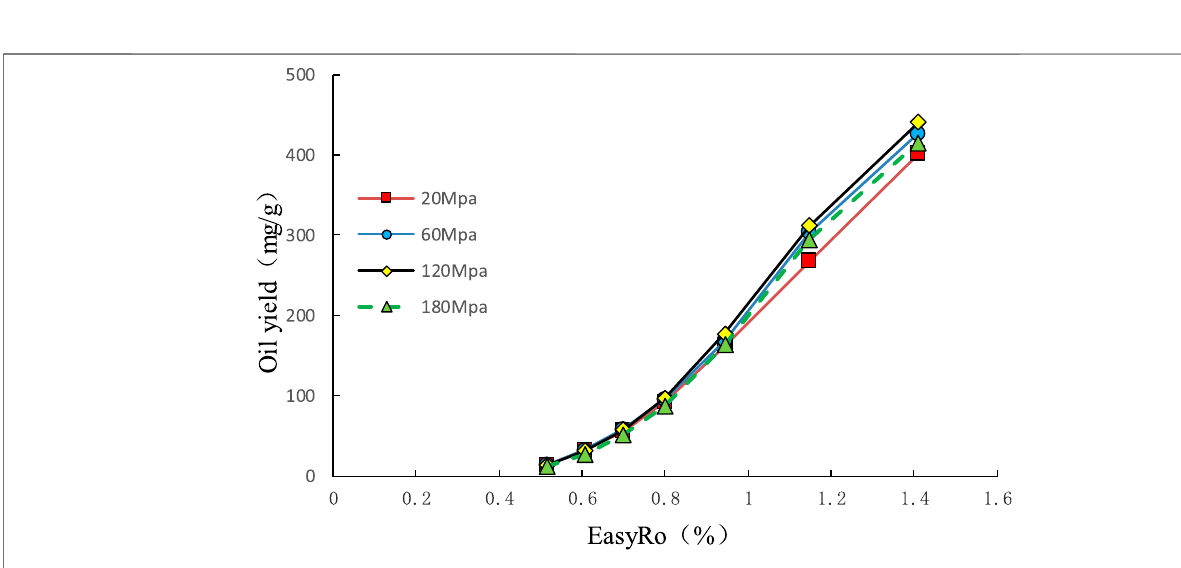
Frontiers in Earth Science |